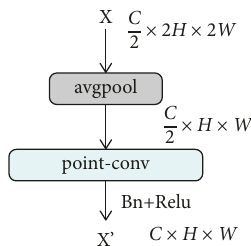
Figure 4: The structure of D-S module.